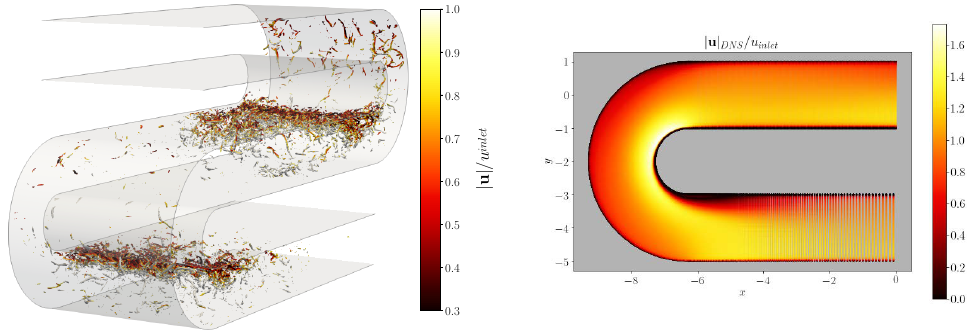
Figure 2. Q-Criterion iso-contours ( Q = 100) and time average velocity along second